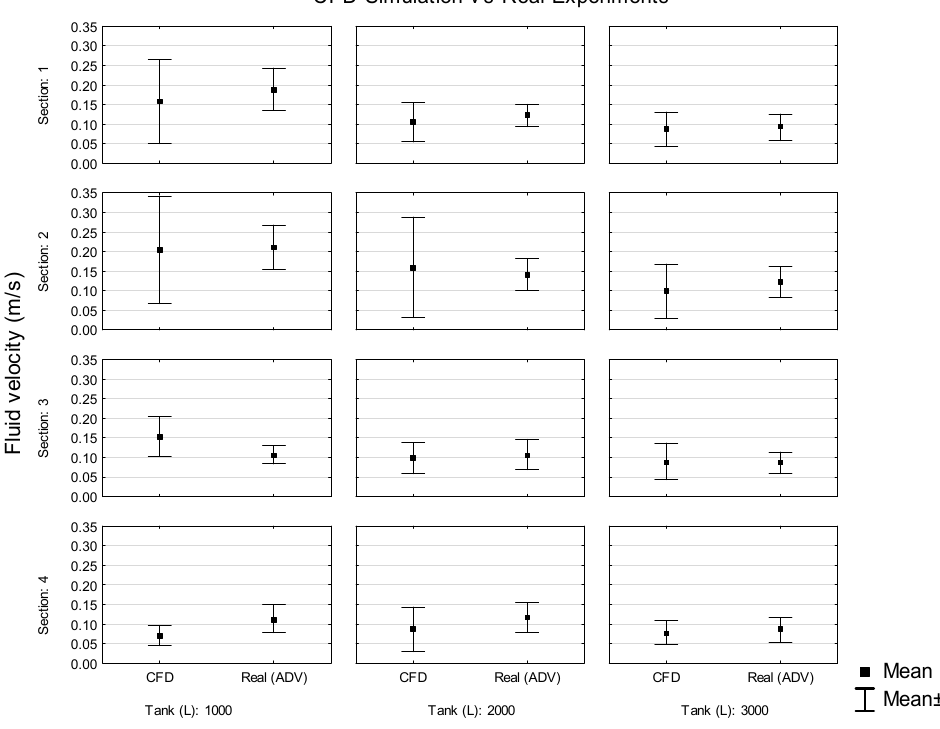
Figure 10. Mean fluid velocities, estimated by CFD and experimentally measured, according to the section of the measurement point.